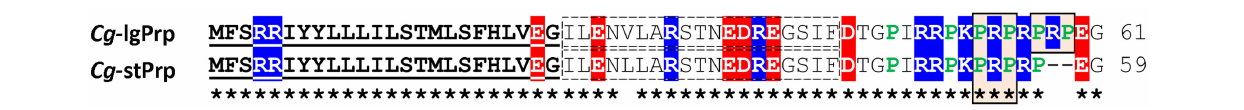
across species, no further structure similarity has been evidenced until now between oyster Prps and other proline-rich peptides.The amino acid sequences displayed here for Cg -lgPrp and Cg -stPrp correspond to GenBank FJ669361 and FJ669381, respectively. Amino acids are numbered on the right. Conserved residues are shown by an asterisk. Conserved Lys/Arg and Asp/Glu residues are highlighted in blue and red, respectively. Pro residues are shown in